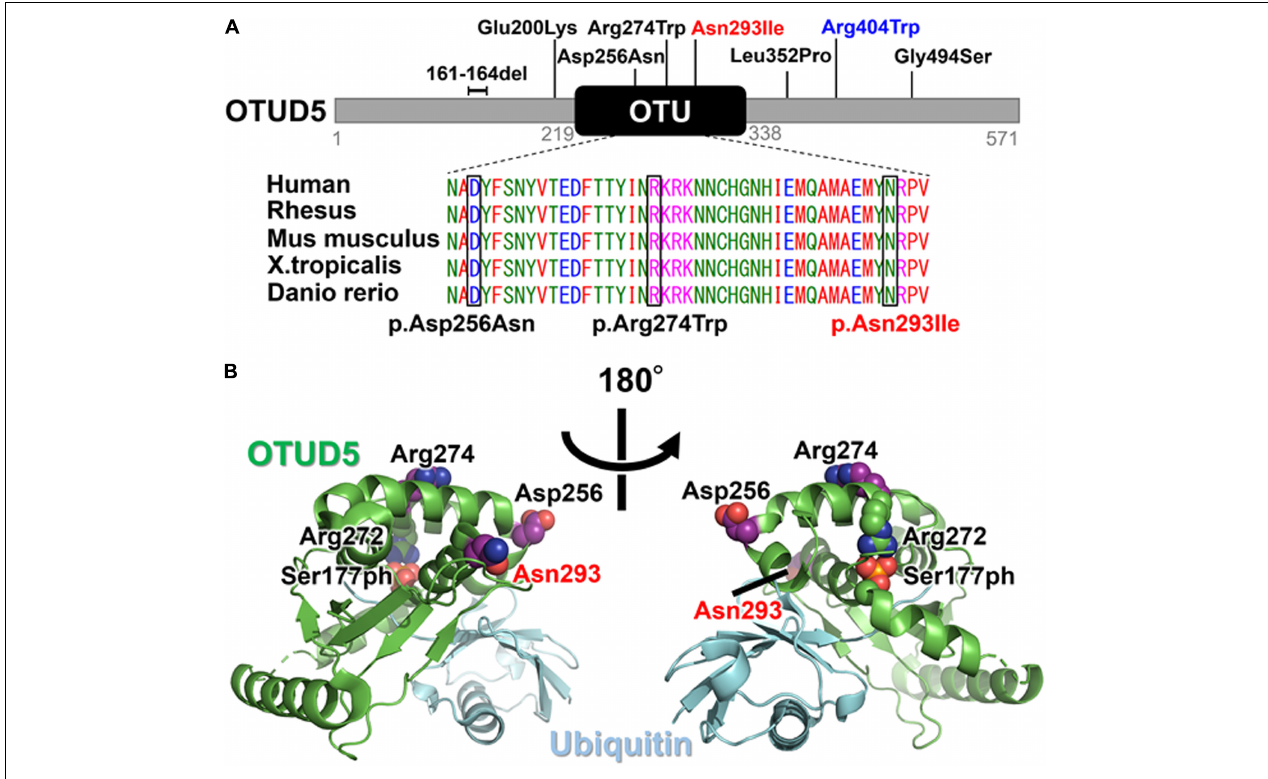
FIGURE 3 | (A) Schematic presentation of the OTUD5 protein and the pathogenic variants. The affected amino acid in the OTU domain is conserved among several species, from humans to fish. The protein sequences of the different species were aligned using Clustal Omega. The previously reported variants are in black and the novel variant (Asn293Ile) is shown in red above the protein. The recurrent variant (Arg404Trp) identified in this study and reported by Beck et al. is shown in blue. (B) The crystal structure of the Ser177-phosphorylated form of OTUD5 bound with ubiquitin (PDB ID: 3TMP). OTUD5 and ubiquitin are shown in green and cyan, respectively. The pathogenic variant positions (Asp256, Arg274, and Asn293) are